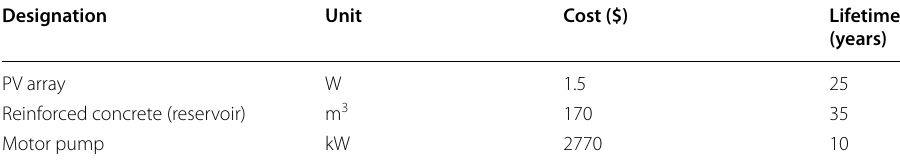
Table 2 Cost of key